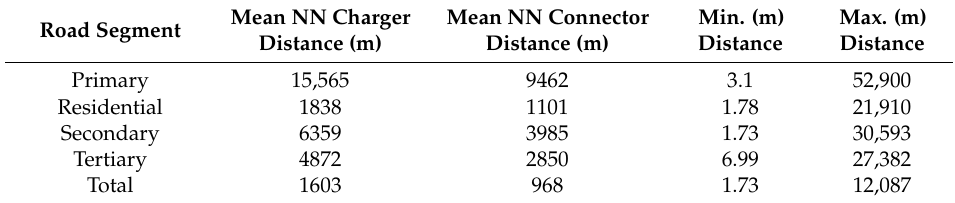
Table 1. Nearest neighbor (NN) average distances to connector based on Reference